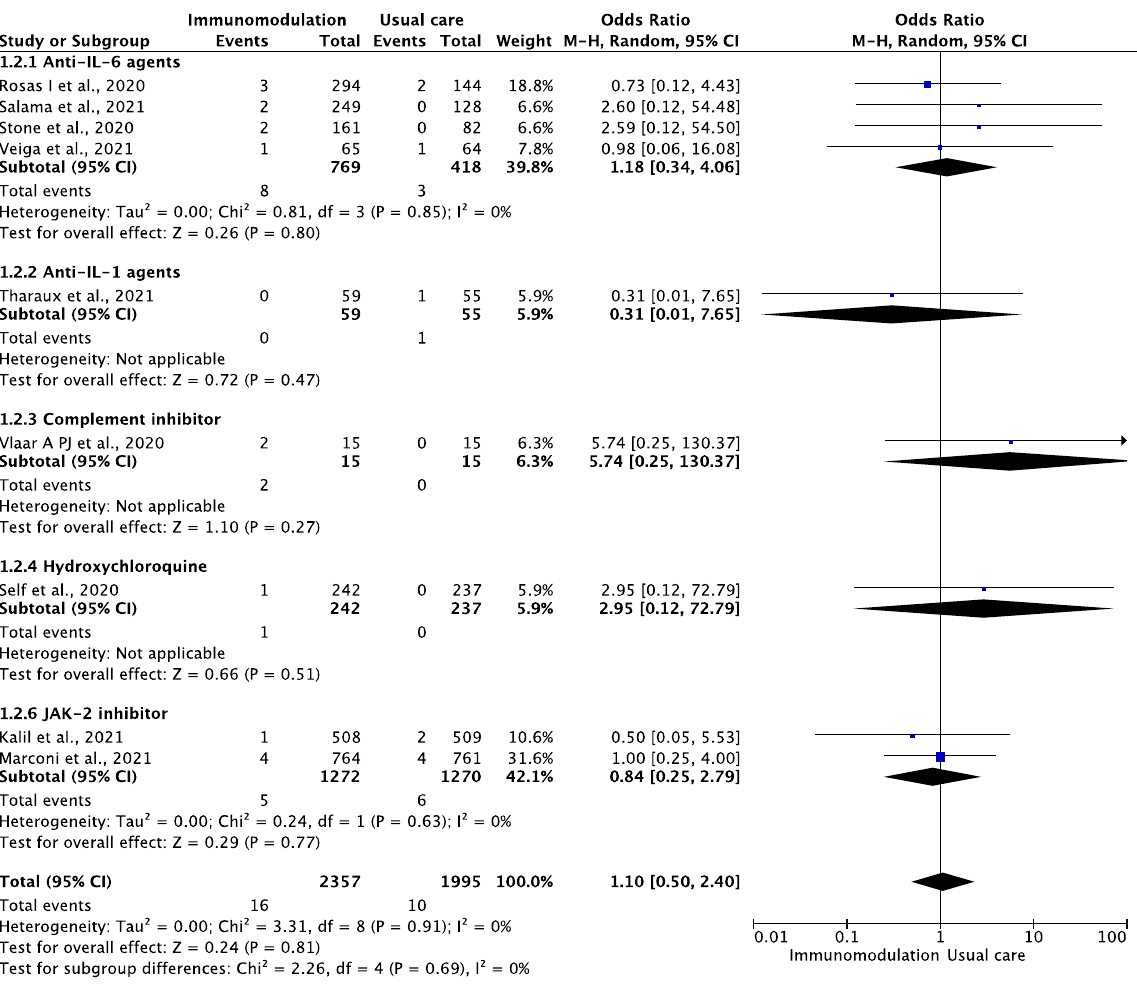
Figure 2. Odds ratio (OR) and 95% confidence intervals for the occurrence of ischemic stroke or systemic embolism among the hospitalized COVID-19 patients prescribed immunomodulatory agents as an add-on to usual care vs. usual care only. Boxes represent the OR and lines represent the 95% CIs for individual studies. The diamonds and their width represent the pooled ORs and the 95% CIs, respectively. CI, confidence interval for the Mantel–Hansen estimator, I2: heterogeneity .